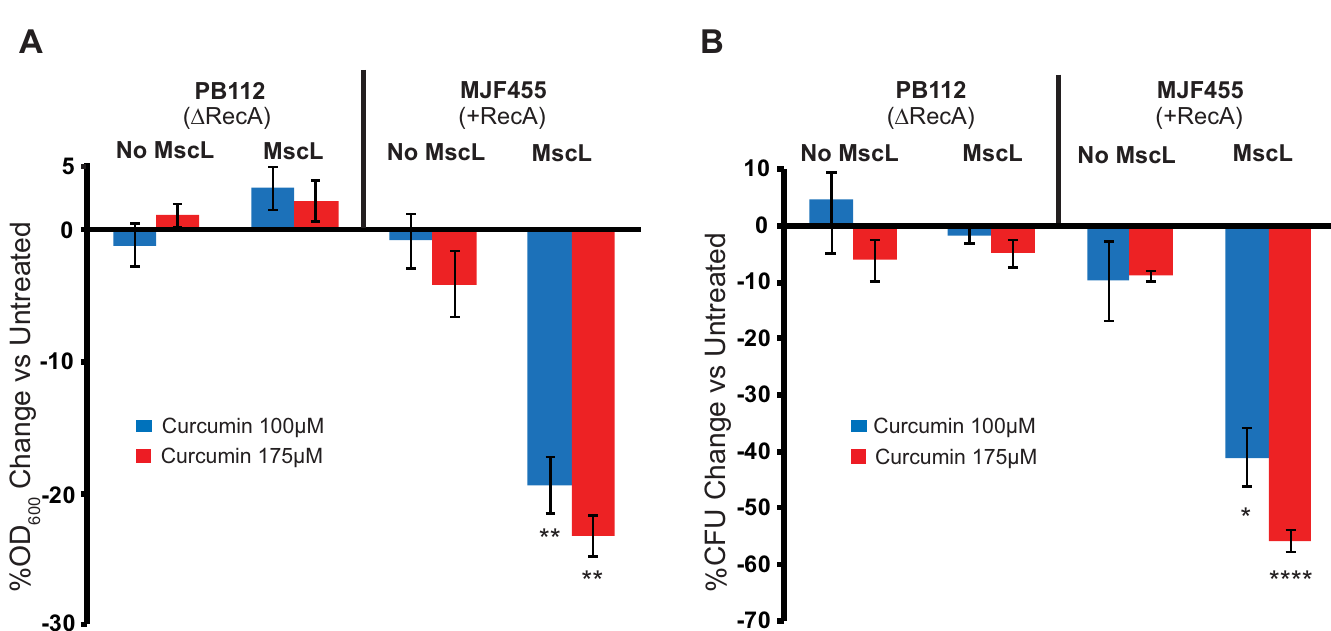
Fig 4. Both RecA and MscL are required for curcumin antibiotic action. Shown are the E . coli Stains PB112 ( Δ recA, Δ MscL, Δ MscS) and MJF455 ( Δ MscL, Δ MscS) carrying vector only (No MscL) or expressing MscL (MscL), treated with curcumin at 100 μ M (blue) or 175 μ M (red). A) Inhibition of growth (OD 600 ) in the presence of curcumin expressed as the percentage change of the untreated. B) The reduction in viability of cultures shown in A, expressed as the percent change of colony forming units (CFUs) vs Untreated. n = 3–5, Statistics reflect a comparison of MscL-expressing versus “no MscL” strains � P < 0.05, �� P < 0.005 ���� P < 0.00005 as indicated, 2 tailed, homoscedastic t-test.